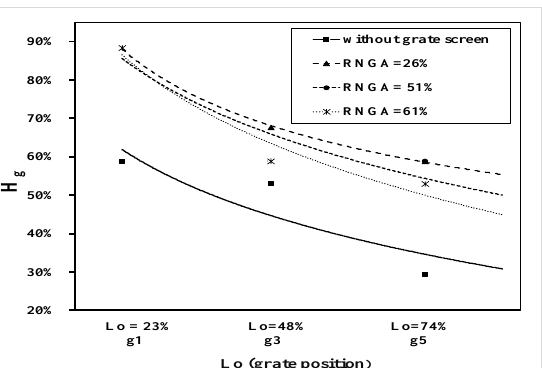
Figure 12. Relationship between relative water height of grate and relative grate distance for different grate inlet areas at (Q = 1.2 L/s).